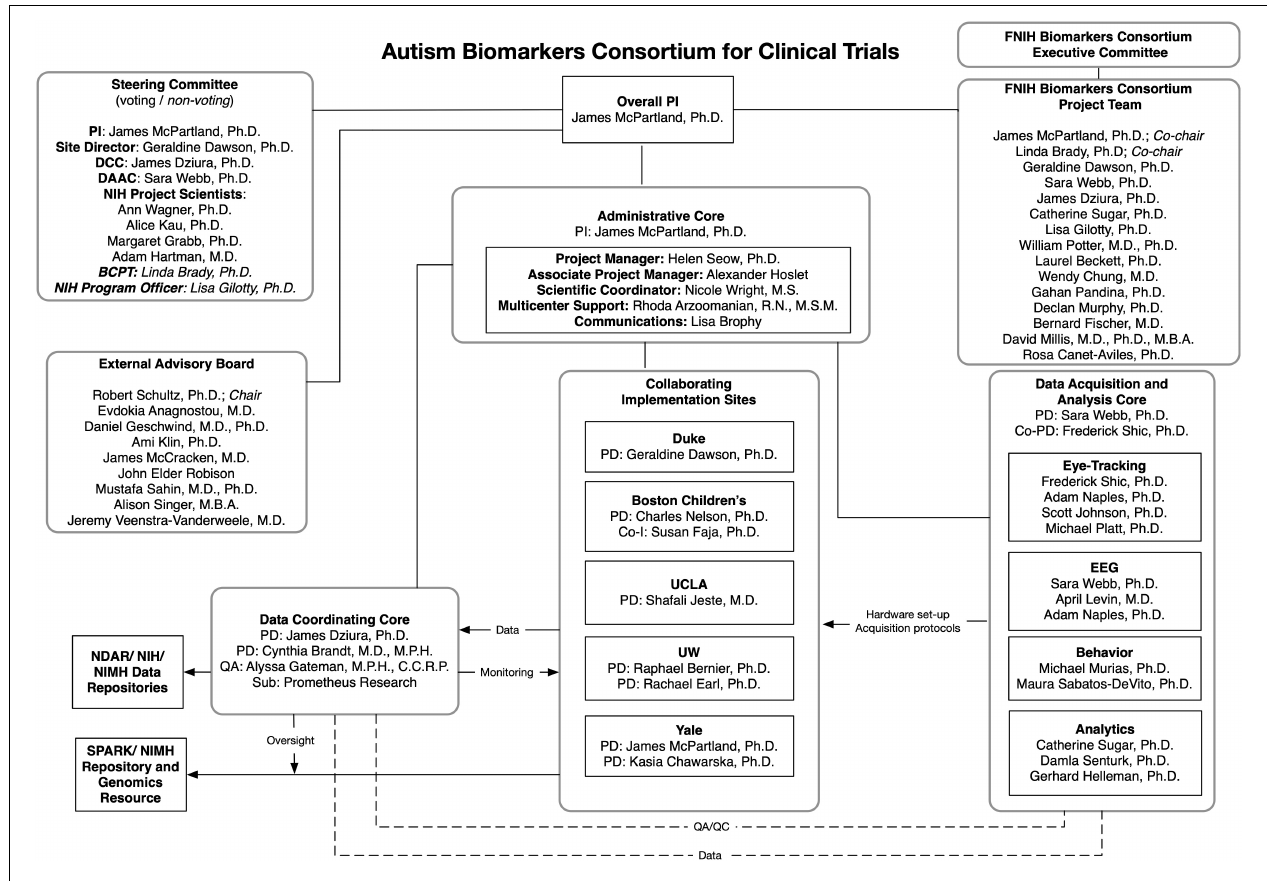
FIGURE 1 | ABC-CT organizational